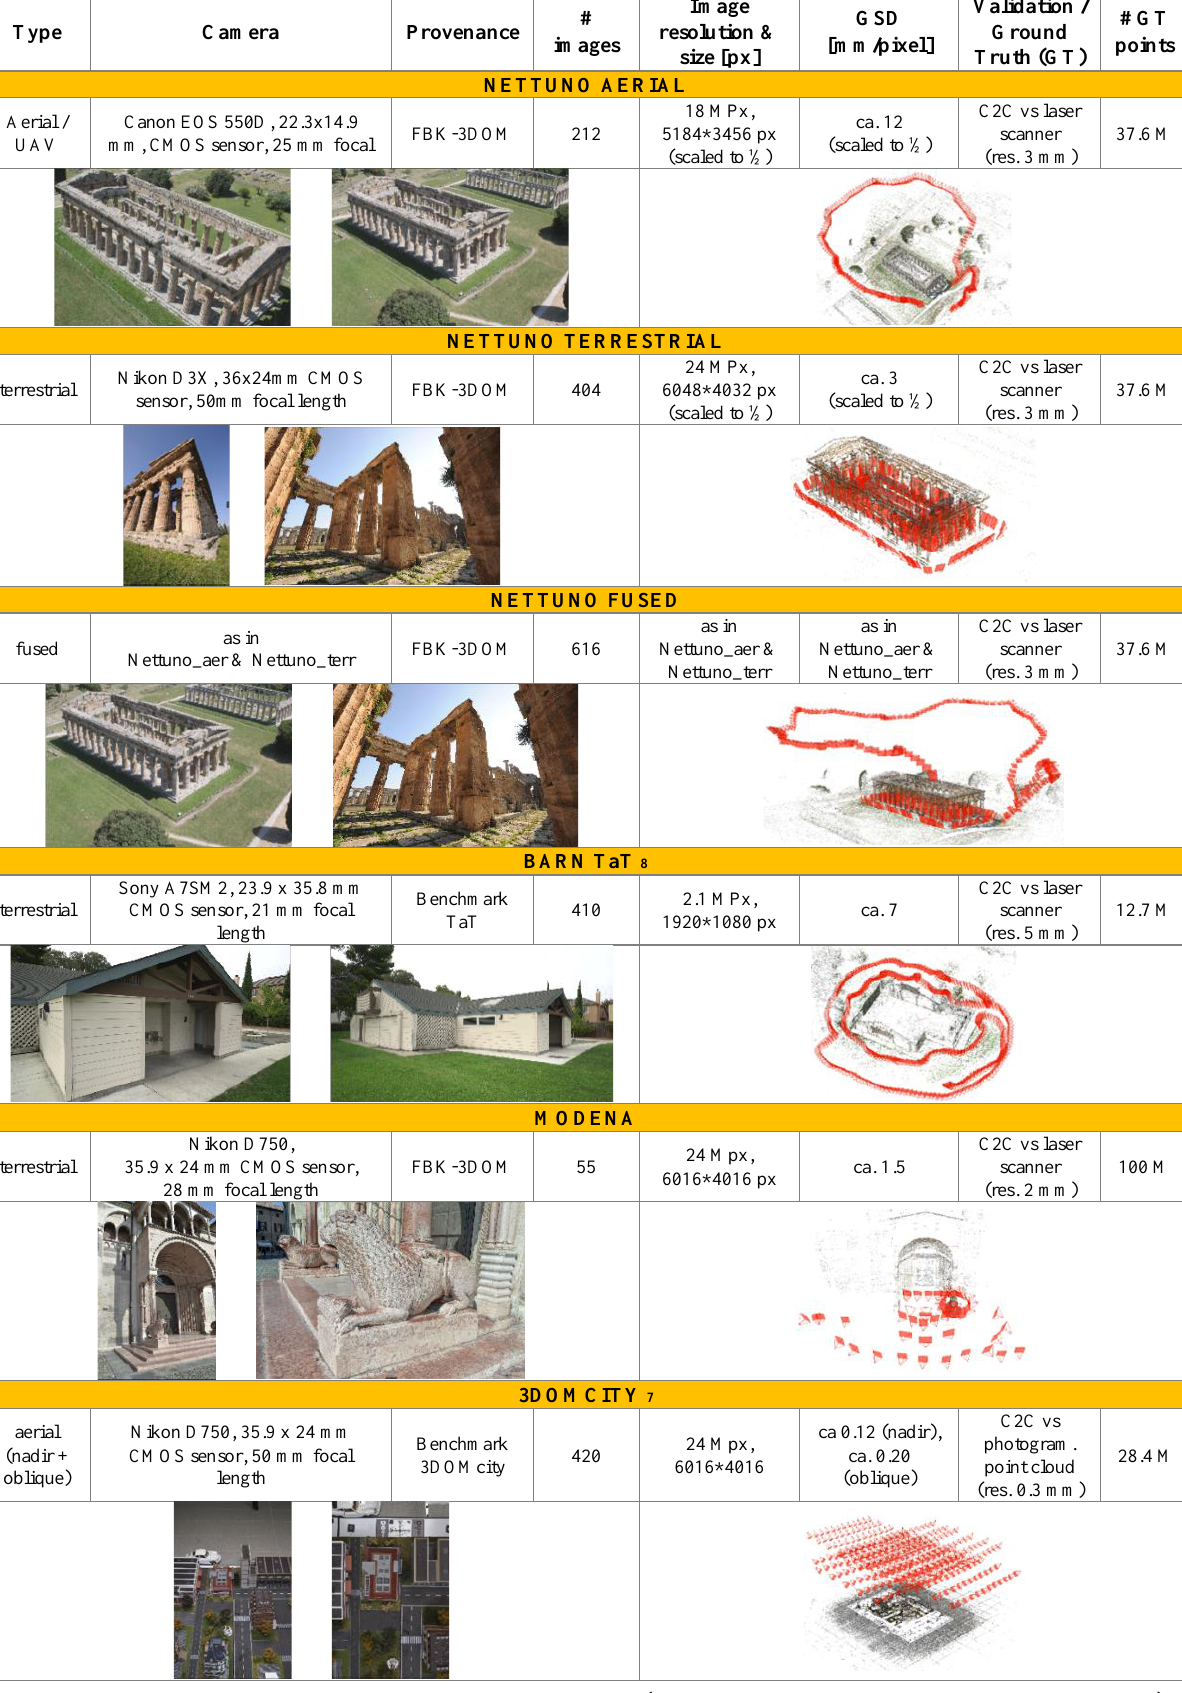
Table 3. Scenarios and datasets considered in the presented evaluation (C2C = Cloud to Cloud comparison; GT = Ground